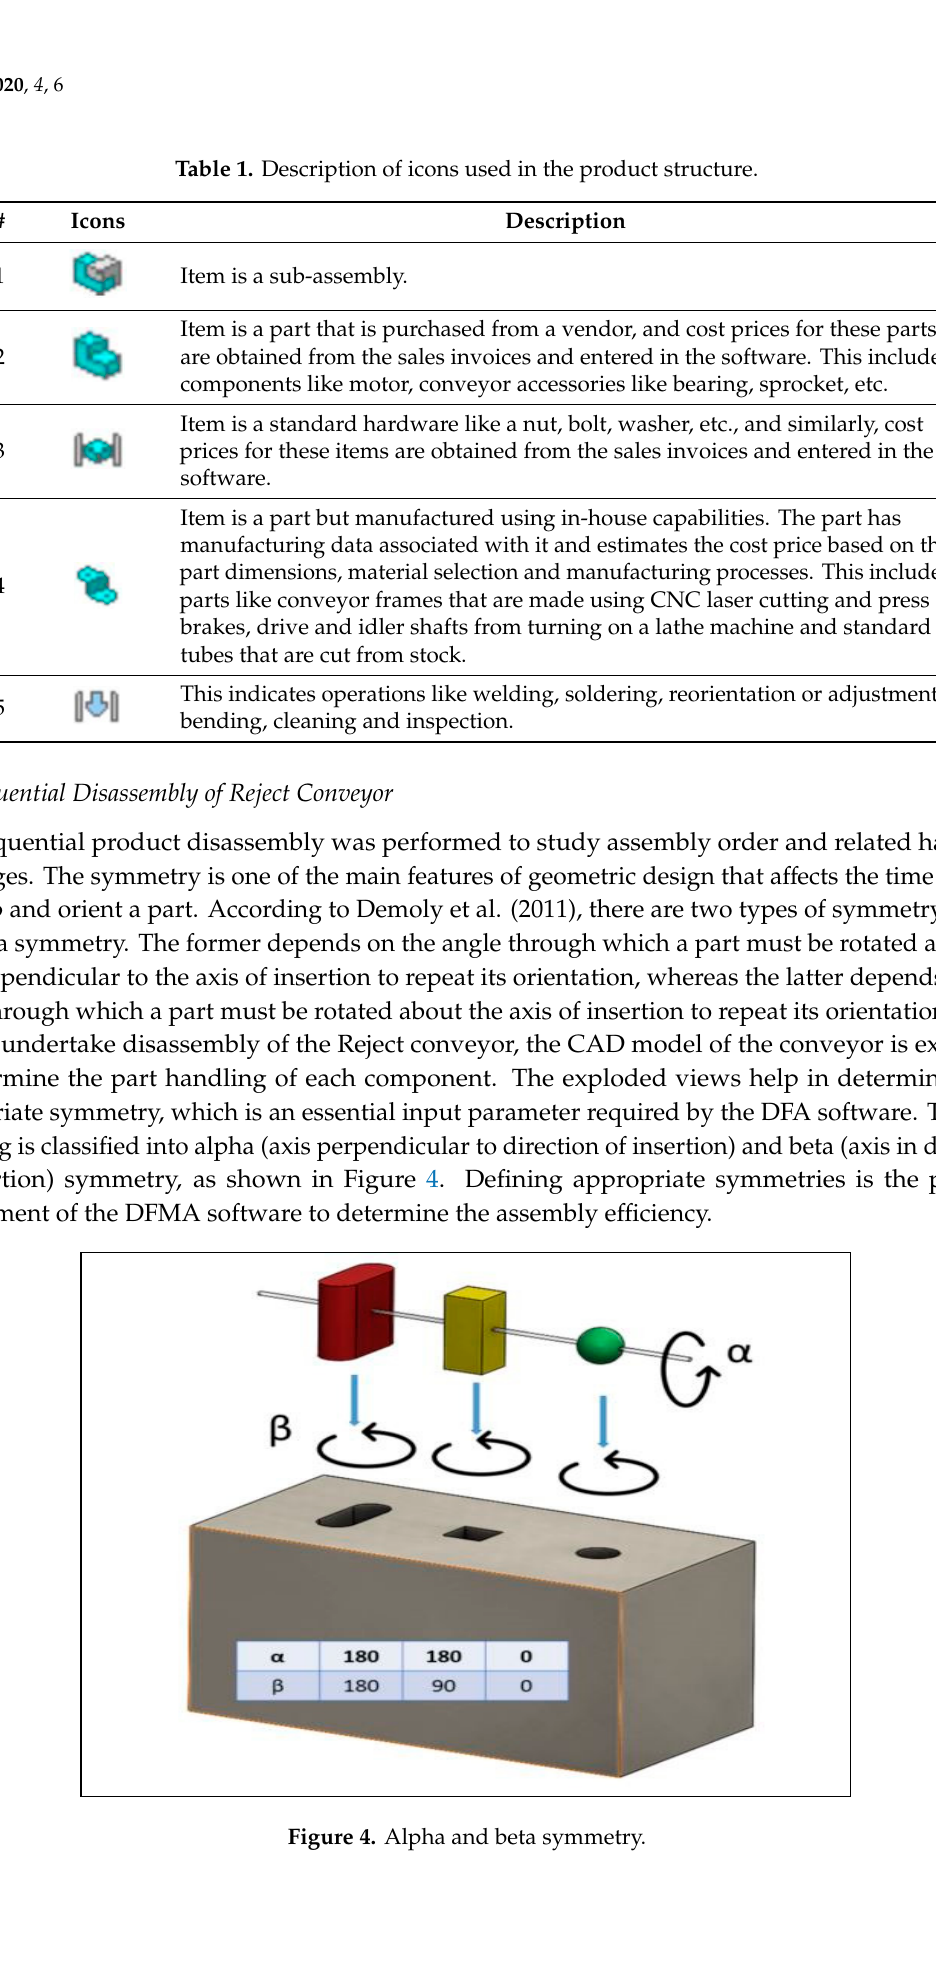
Table 1. Description of icons used in the product structure.